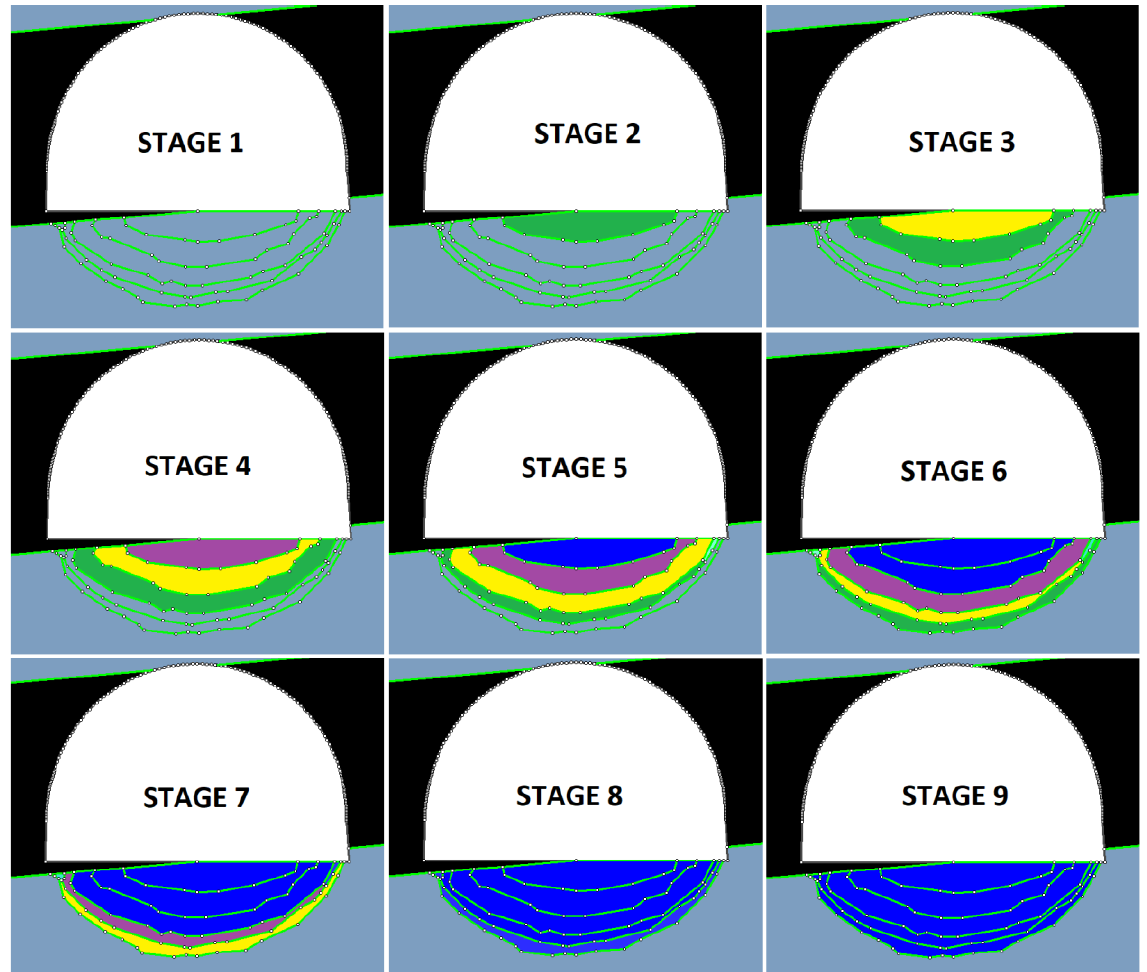
Figure 26. Stages of the numerical simulation of the impact of water saturation of the rocks beneath the floor of roadway D-2 on the magnitude of the floor heave, and with various geomechanical properties: gray color — dry rocks, green — rocks after 3 h of soaking with water, yellow — rocks after 6 h of soaking, purple — rocks after 12 h of soaking, dark blue — rocks after 24 h of soaking. Table 6. Comparison of the convergence results from numerical model of roadway D-2 with the in situ measurements of the 614th meter of the roadway.